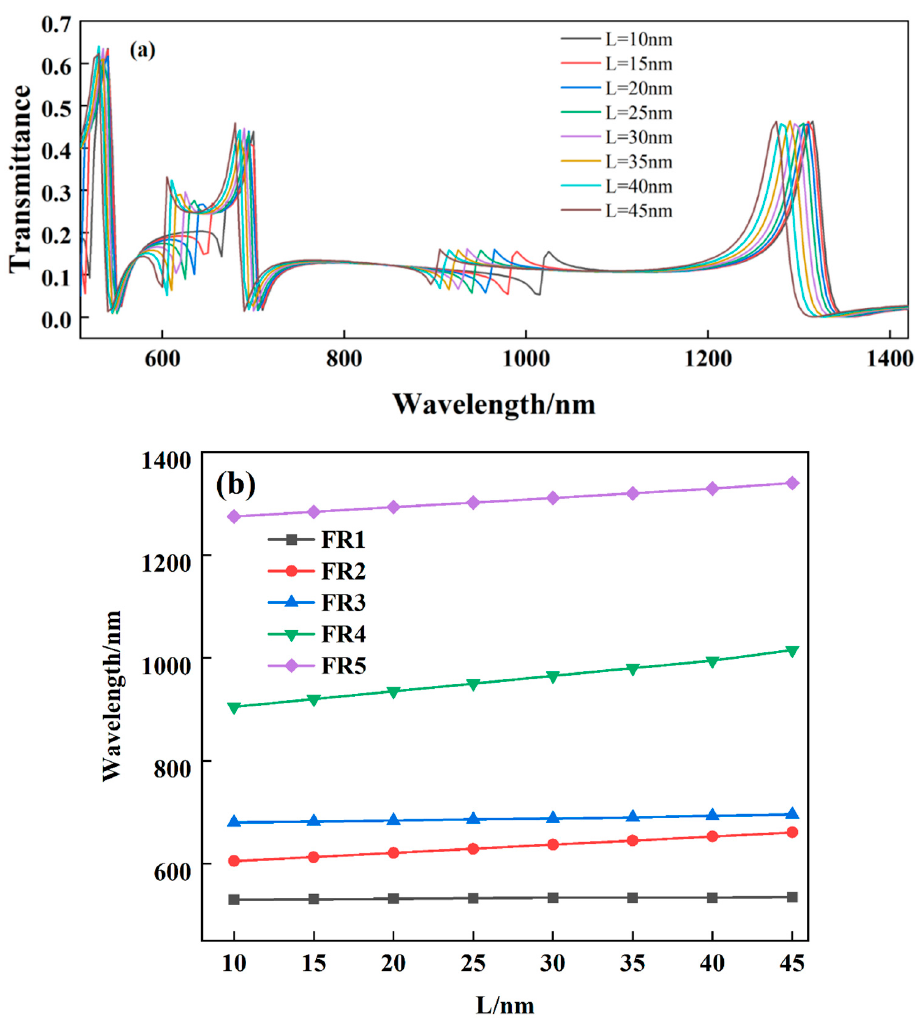
Figure 5. ( a ) Influence of different L on the structural Fano resonances. ( b ) Fano resonance wave- lengths of structures at different L.